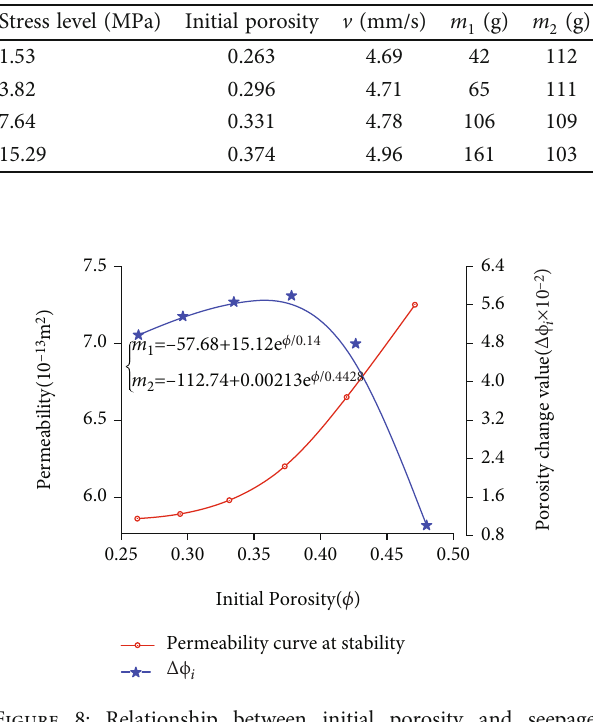
Figure 8: Relationship between initial porosity and seepage characteristics under axial